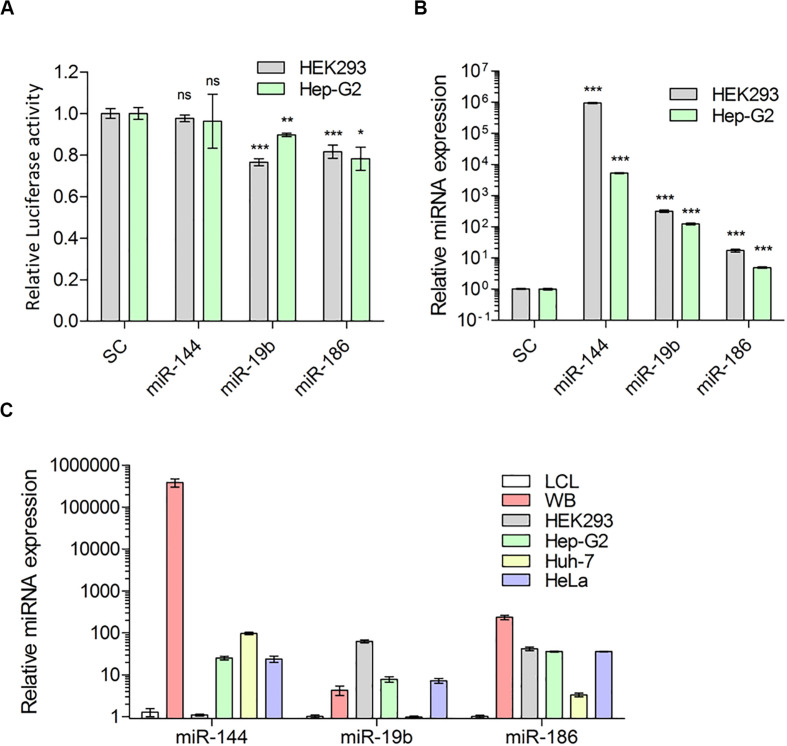
Predicted miRNAs indeed target 3′UTR of F8-mRNA. (A) Relative luciferase activity in HEK-293T and Hep-G2 cells transfected with luciferase reporter plasmid pEZX-MT05 and miRNA expression vectors (pEZX-MR04), for miR-144, miR-19b and miR-186 and scrambled miRNA as control (SC) (Mean ± SEM for HEK293: SC = 0.993 ± 0.024, N = 15; miR-144 = 0.977 ± 0.017, N = 6; miR-19b = 0.7656 ± 0.017, N = 6; miR-186 = 0.816 ± 0.035, N = 15 and for Hep-G2: SC = 0.999 ± 0.078, N = 6; miR-144 = 0.962 ± 0.013, N = 6; miR-19b = 0.897 ± 0.032, N = 6; miR-186 = 0.782 ± 0.055, N = 9). (B) QPCR analysis to determine overexpression level of miRNAs 72 h after transfection (Mean ± SEM for HEK-293T: SC = 1.020 ± 0.023, N = 4; miR-144 = 946505 ± 40246, N = 3; miR-19b = 320.2 ± 31.61, N = 3; miR-186 = 17.39 ± 1.91, N = 6 and for Hep-G2: SC = 1.001 ± 0.039, N = 4; miR-144 = 5358 ± 208.3, N = 3; miR-19b = 124.5 ± 8.98, N = 3; miR-186 = 4.392 ± 0.257, N = 8) and (C) expression of endogenous miRNAs: miR-144, miR-19b and miR-186 in whole blood (WB from two healthy donors), HEK-293T, liver cell lines: Hep-G2, Huh-7, and HeLa, relative to LCL cells (Mean ± SEM for miR-144: LCL = 1.281 ± 0.287, N = 6; WB = 386,400 ± 84274, N = 6; HEK-293 = 1.100 ± 0.057, N = 3; Hep-G2 = 25.39 ± 2.53, N = 3; Huh-7 = 97.2 ± 6.73, N = 3 and HeLa = 23.94 ± 4.11, N = 3; for miR-19b: LCL = 1.020 ± 0.089, N = 6; WB = 4.303 ± 1.082, N = 6; HEK-293 = 63.34 ± 5.204, N = 3; Hep-G2 = 7.820 ± 1.190, N = 3; Huh-7 = 0.985 ± 0.005, N = 3 and HeLa = 7.225 ± 0.935, N = 3; and for miR-186: LCL = 1.015 ± 0.075, N = 6; WB = 235.9 ± 28.74, N = 6; HEK-293 = 49.02 ± 4.074, N = 3; Hep-G2 = 36.14 ± 1.414, N = 3; Huh-7 = 3.336 ± 0.362, N = 3; and HeLa = 36.03 ± 0.81, N = 3). *P < 0.05; **P < 0.01; ***P < 0.001.